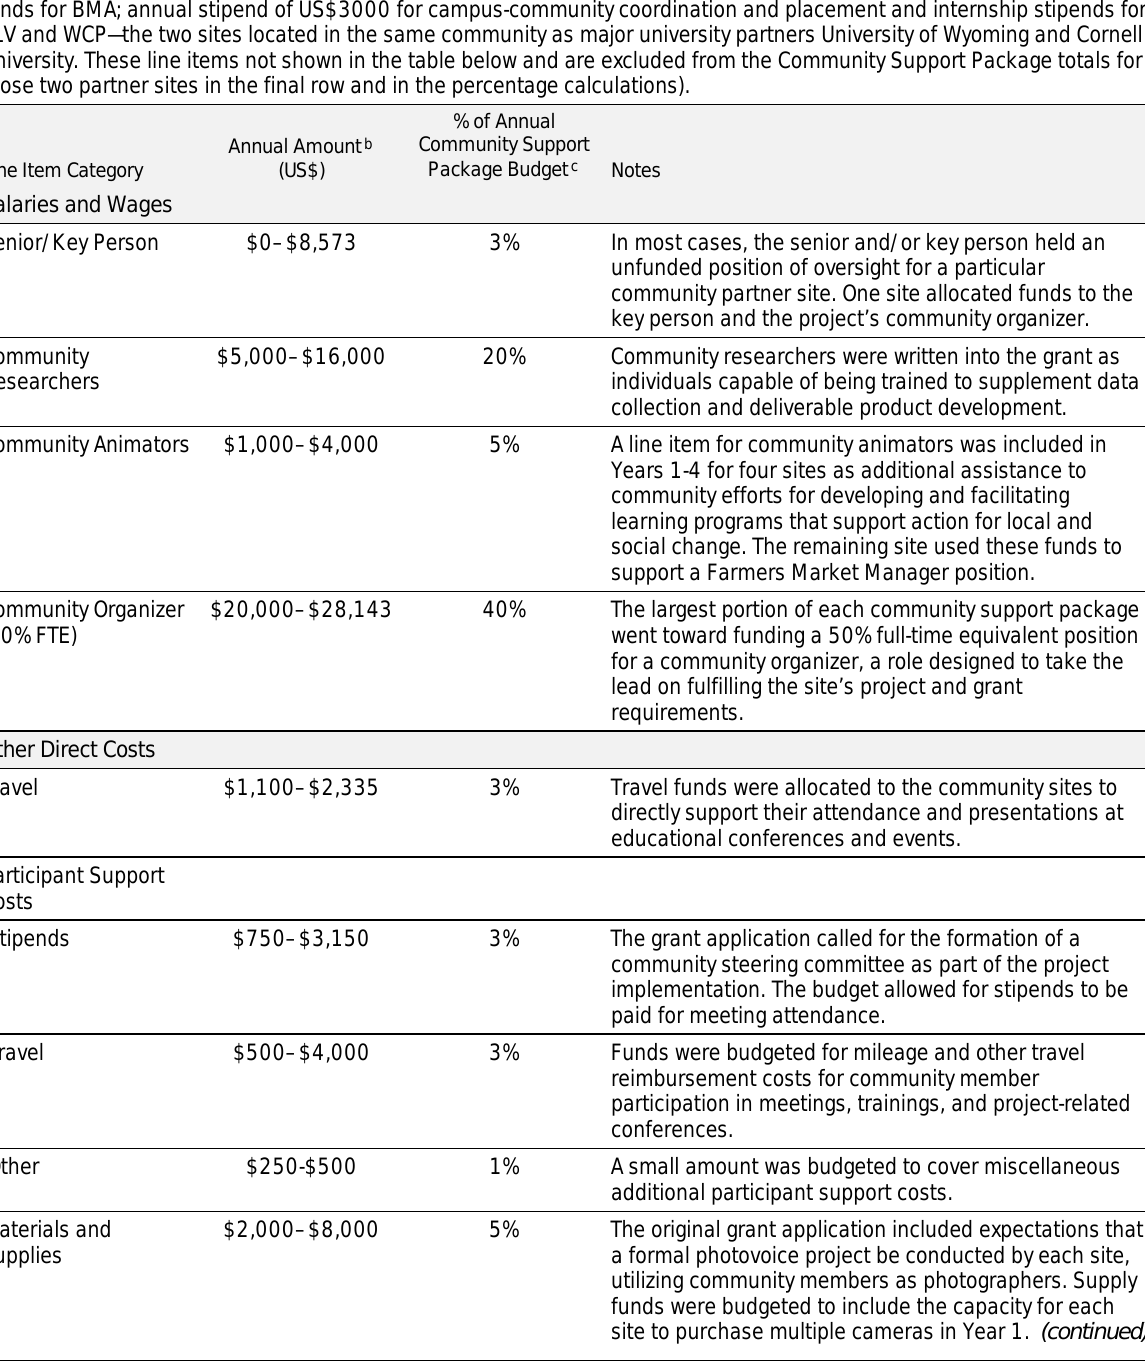
Table 1. Food Dignity Community Support Package Categories as Originally Proposed a General allocation note: The budget was designed on a graduated basis from year to year. Some line items increased each year (such as the one for the community organizer), while others waxed and waned according to project requirements in any given year (e.g., minigrant funds started low, peaked in Years 2–3, and ended after year 4; materials and supplies allowed for upfront expenditures in Year 1 to enable the site to invest in project-necessary items). The range of funding levels between sites at the time of the grant award were the result of geographically-based average salary range differences for the community organizer, line item funding unique to a particular site (e.g., farmers market management funds for BMA; annual stipend of US$3000 for campus-community coordination and placement and internship stipends for FLV and WCP—the two sites located in the same community as major university partners University of Wyoming and Cornell University. These line items not shown in the table below and are excluded from the Community Support Package totals for those two partner sites in the final row and in the percentage